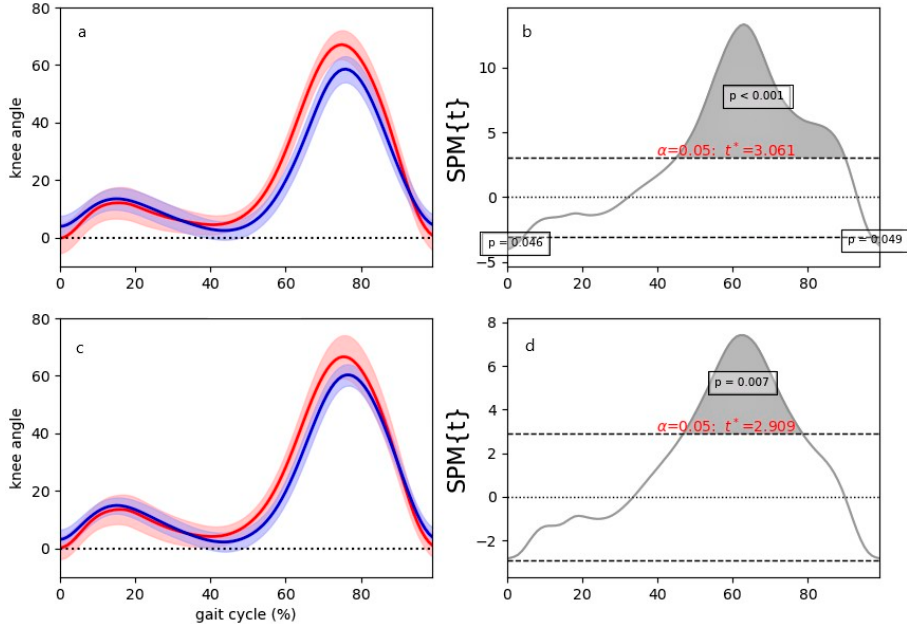
Figure 6. Results of the SPM analysis. ( a , c ) Mean curves (solid lines) and SD (shades); x-axis = knee angle, and y-axis = % of gait cycle. ( b , d ) SPM results with α level (0.05) based on the t-distribution (dotted lines) and p -values; x-axis = t-values, and y-axis = % of gait cycle. Table 2. Ratings (mean ± SD) for the four feedback versions (Soni 1.1–Soni 2.2) in the two dimensions on a Likert scale of 1–6 ( N = 28